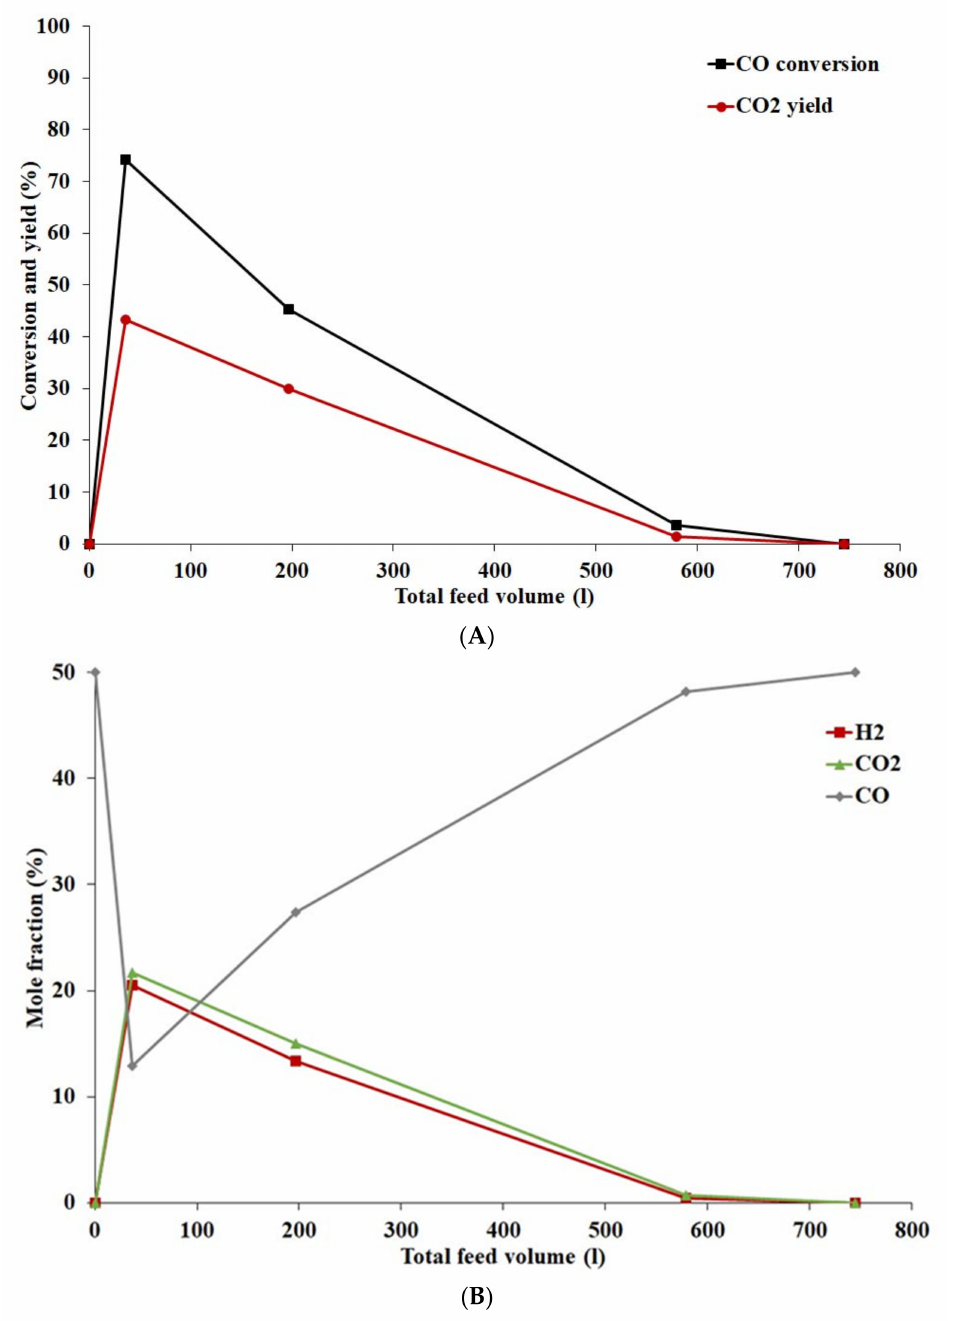
Figure 16. Catalytic tests on a Cu-based (14.8 wt%) activated catalyst, prepared with calcined support, with feed gas mixture 2 (50 mole% CO, 0.4 mole% H 2 S, balance N 2 ) at pressure 6 MPa: ( A )—CO conversion and CO 2 yield; ( B )—composition of the produced